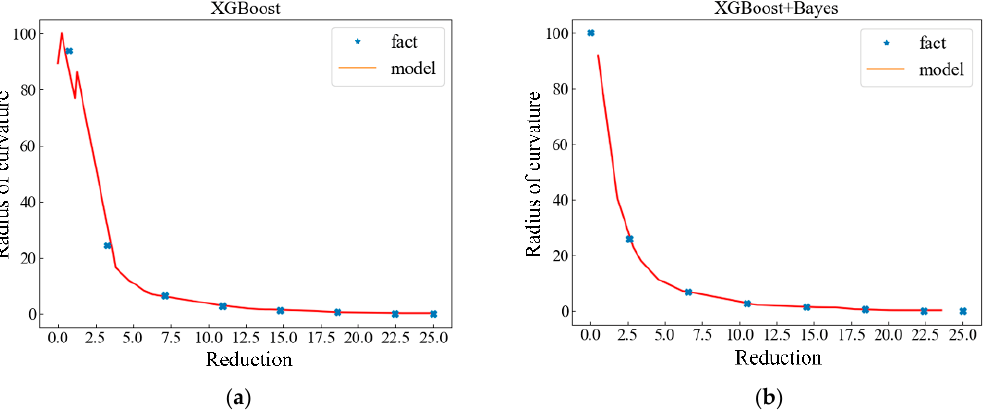
Figure 10. Comparison between the initial model and the model after Bayesian optimization of hyperparameters. ( a ) Initial hyperparameter combination model effect; ( b ) Model effect after Bayesian optimization of hyperparameters.